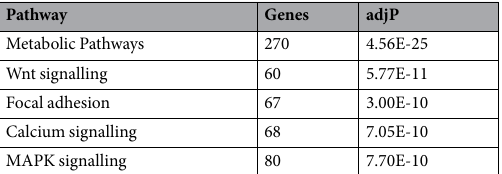
Table 1. KEGG pathway analysis. Shown are the enriched pathways, the number of genes involved and the adjusted P value (adjP, hypergeometric test with Benjamini-Hochberg FDR